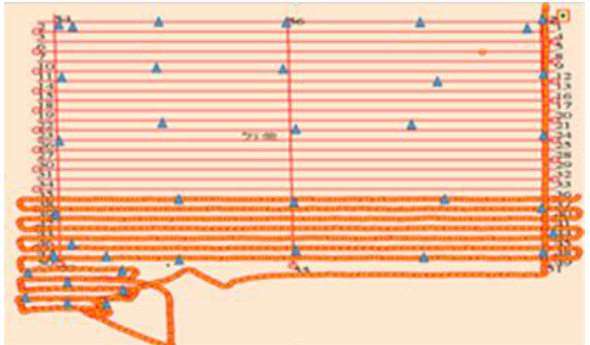
Figure 7.The control strip and flight